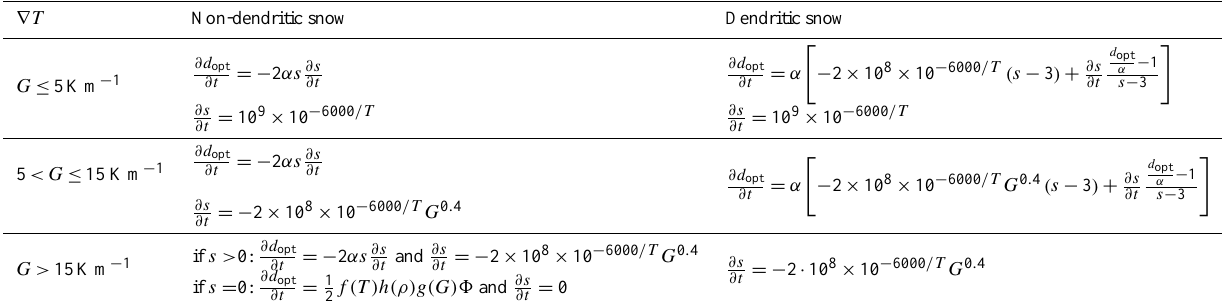
Table 2. Metamorphism laws for formulation C13 in the case of dry snow. G is the vertical temperature gradient ( ∇ T = | ∂T/∂z | , in Km − 1 ), T the temperature (in K) and t the time expressed in days. f , g , h and 8 are empirical functions to predict depth hoar growth rate in the case of high G values (Marbouty, 1980; Vionnet et al., 2012). α is equal to 10 − 4